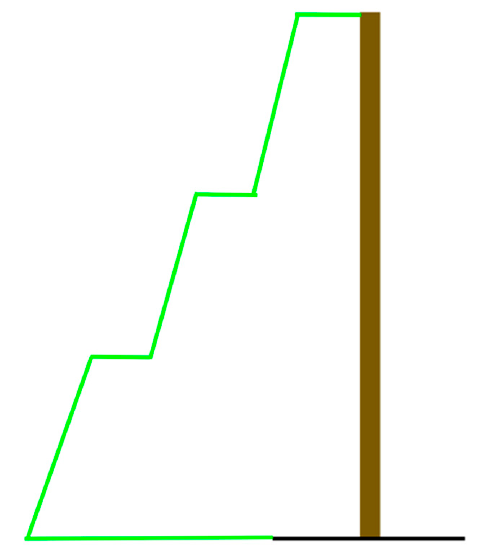
Figure A10. The 6 × 6 Shear Force Diagram. The bending moment diagram of each post is shown in Figure